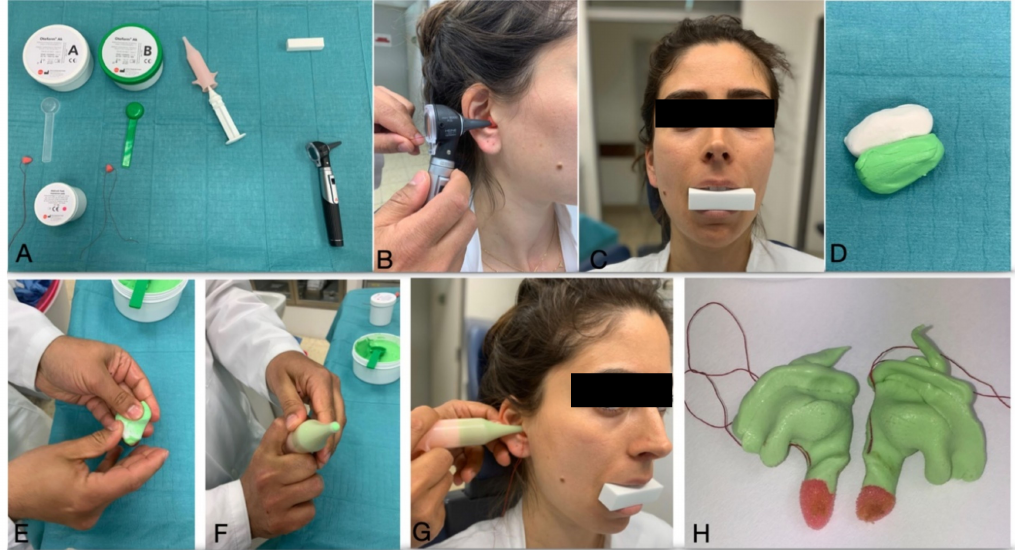
Figure 2. Impression procedure to produce personalized Cerezen in-ear device: ( A ) All materials and instruments needed for taking an impression including: 1—Impression material (Otoform Ak, Dreve Ostoplastik GmbH, Unna, Germany); 2—Impression pads which are a foam cone with thread (Dreve Ostoplastik GmbH, Unna, Germany), 3—Universal syringe to applying the impression material in the ear canal (PC Werth, London, UK); 4—Bite block (Renew Health Limited, Westmeath, Ireland); 5—Otoscope for investigation of the ear canal and insertion of the impression pads in the right position (Heine Optotechnik, Herrsching, Germany) ( B ) Insertion of the impression pads (orang) to protect the ear drum during impression-taking, ( C ) Patient biting on the Bite block to keep the jaw in rest position during the impression-taking ( D – F ) Two-components impression materials, Mixing,preparation for injection, ( G ) Impression-taking while patient biting on the Bite Block to fit the impression in the relaxed status ( H ) Ear canal impressions for both